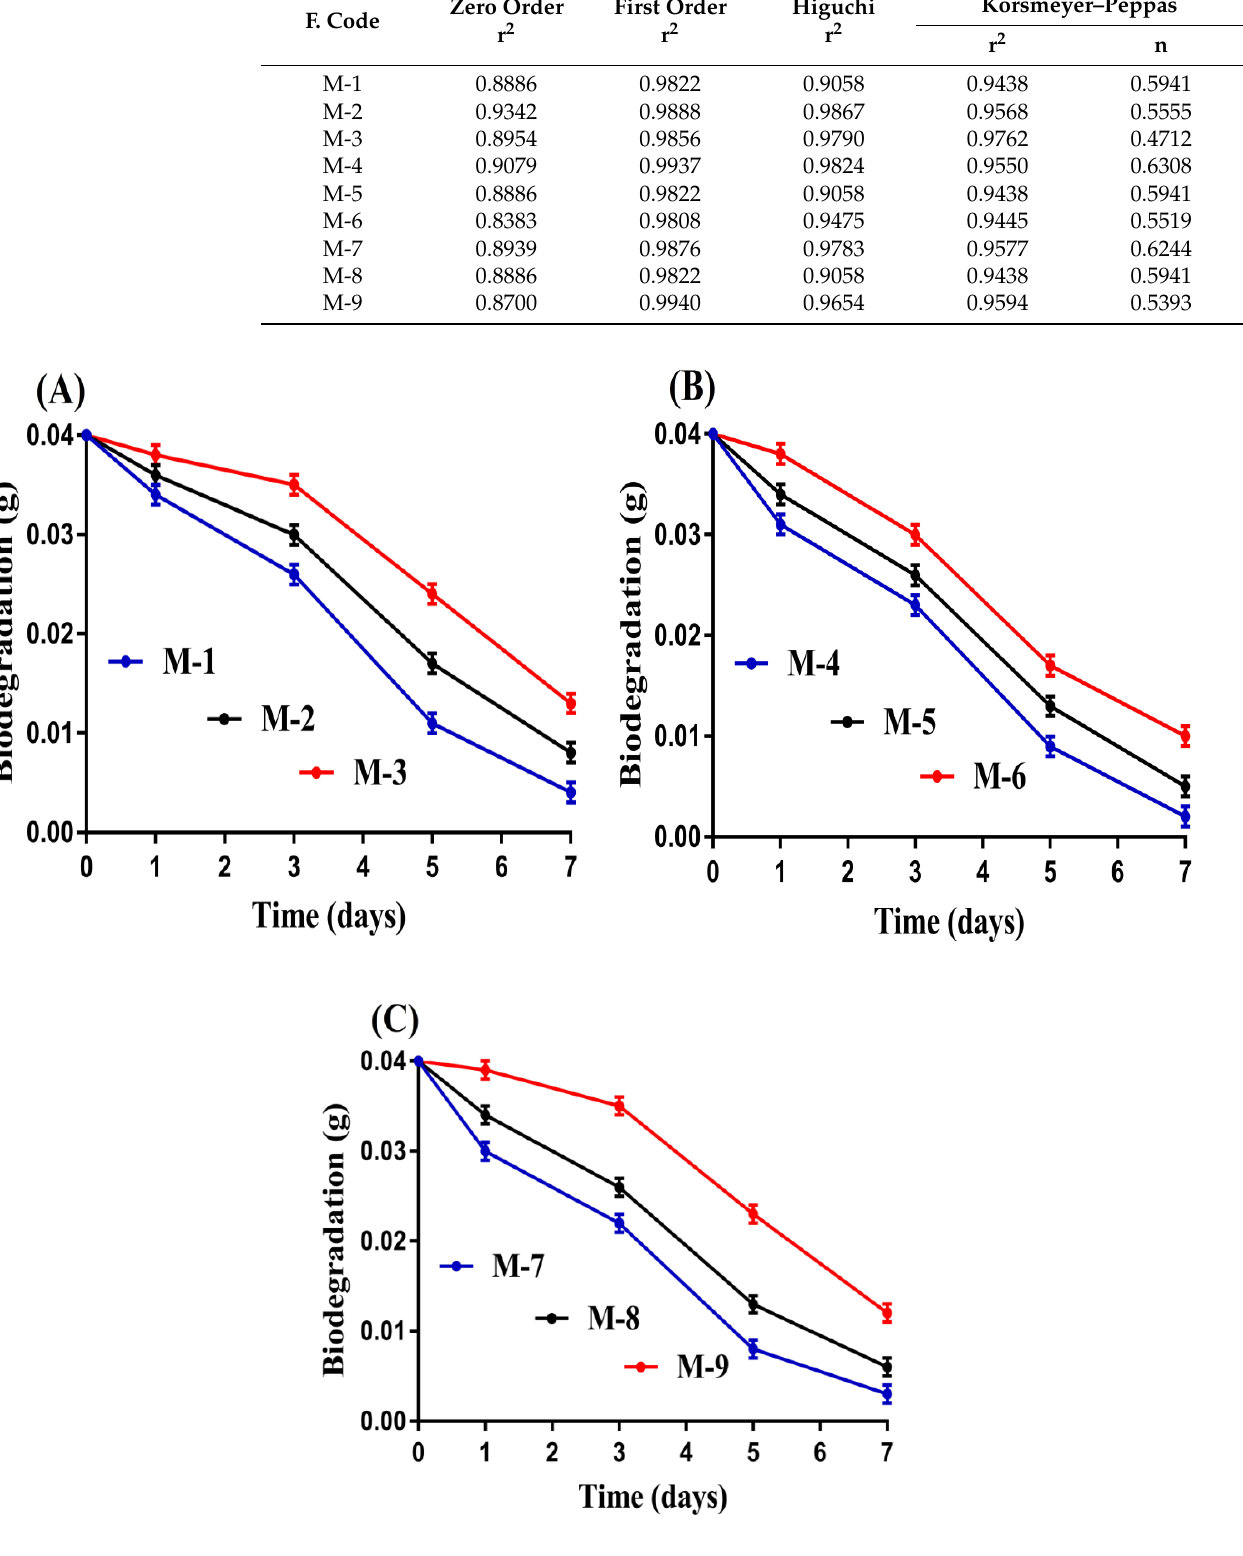
Figure 9. Effect of ( A ) CS, ( B ) Al, and ( C ) Aa on biodegradation of CS/Al-g-pAa hydrogel. 3.15. Comparison of Kt-Loaded CS/Al-g-pAa Hydrogels with Other Kt Delivery Systems